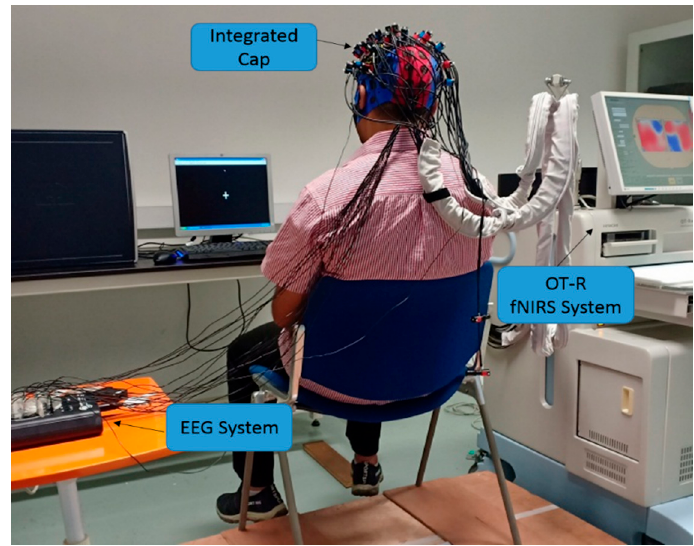
Figure 2. Subject position during the data collection process. EEG electrodes and fNIRS optodes connected to the integrated cap on the subject’s head, with the subject sat on a chair in front of an instruction monitor.